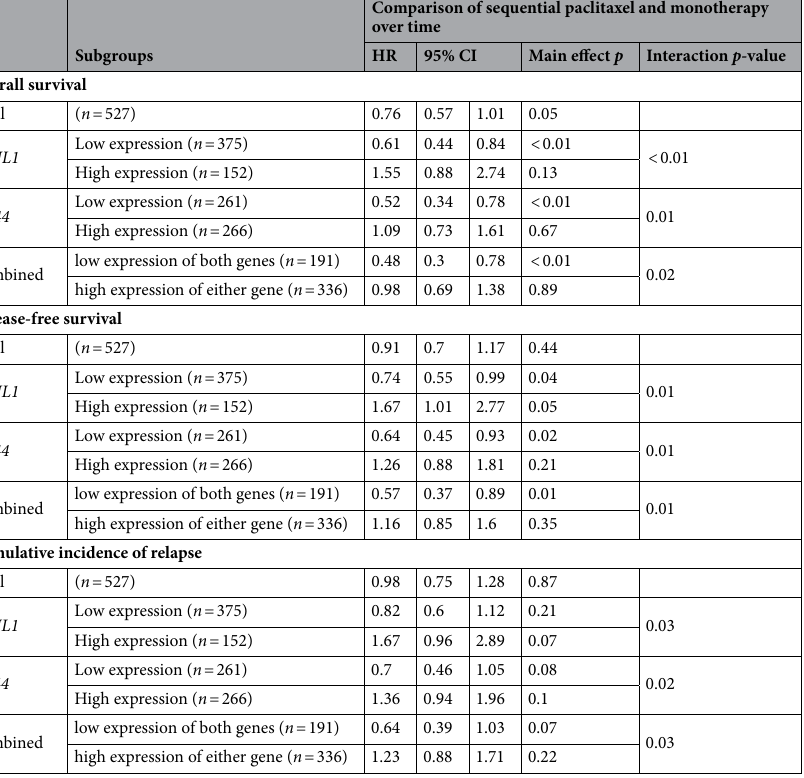
Table 2. Effects of sequential paclitaxel followed by UFT or S-1 on overall survival, disease-free survival, and cumulative incidence of relapse, based on gene expression levels. HR hazard ratio, CI confidence interval, UFT